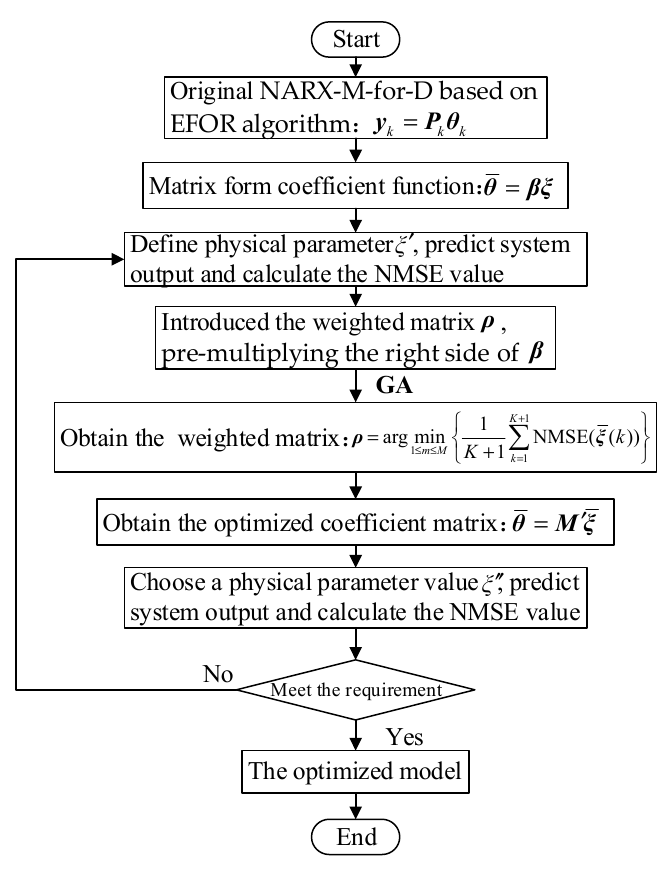
Figure 3. The flowchart of Weighted EFOR (WEFOR) Figure 3. the flowchart of Weighted EFOR (WEFOR) algorithm.